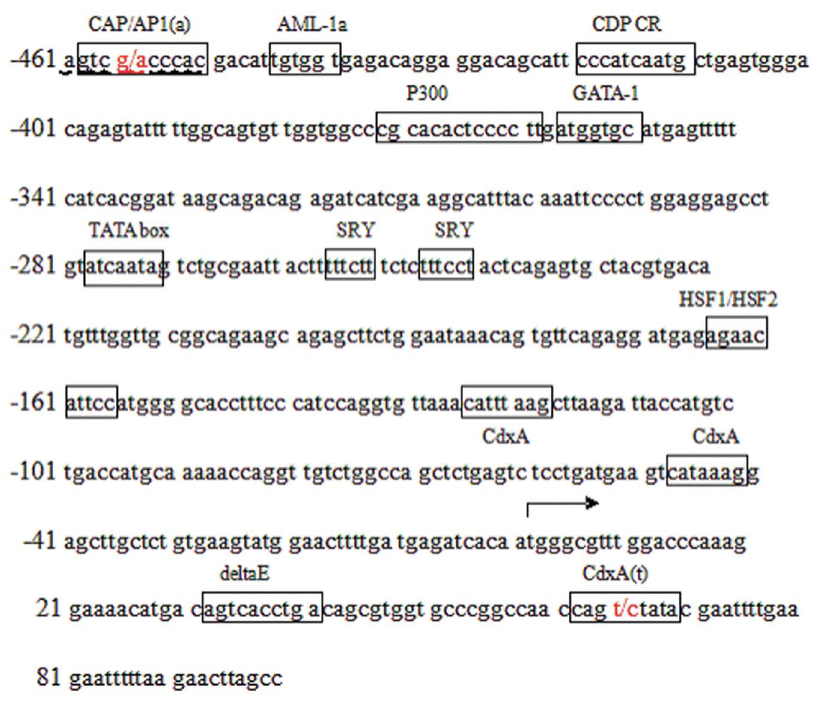
Figure 1. 5 9 -Flanking sequence of bovine PLCz from 2 461 bp to + 100 bp. This fragment contains the promoter exon 1 and a part of intron 1. Boxed sequences represent the putative transcription factor binding sites. The nucleotides highlighted in red represent the two polymorphic sites in Chinese Holstein bulls. The nucleotide sequence numbered + 1 is A of the TSS. The numbering of nucleotides is relative to the transcription start site.